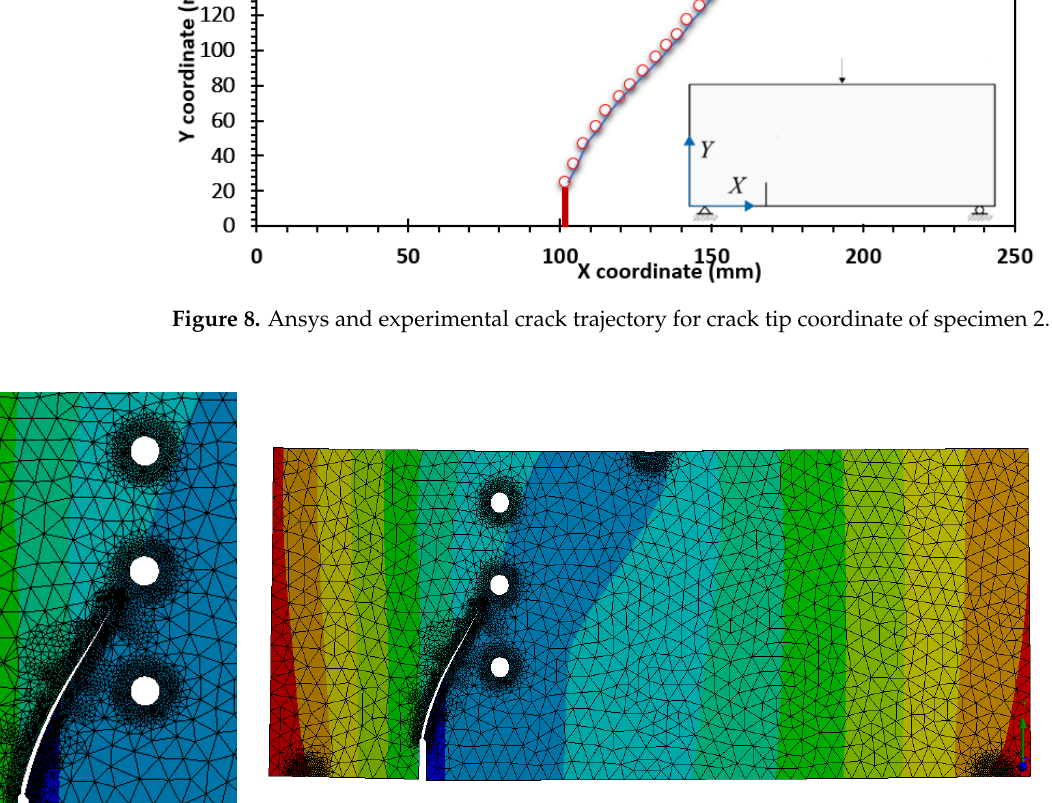
Figure 8. Ansys and experimental crack trajectory for crack tip coordinate of specimen 2.